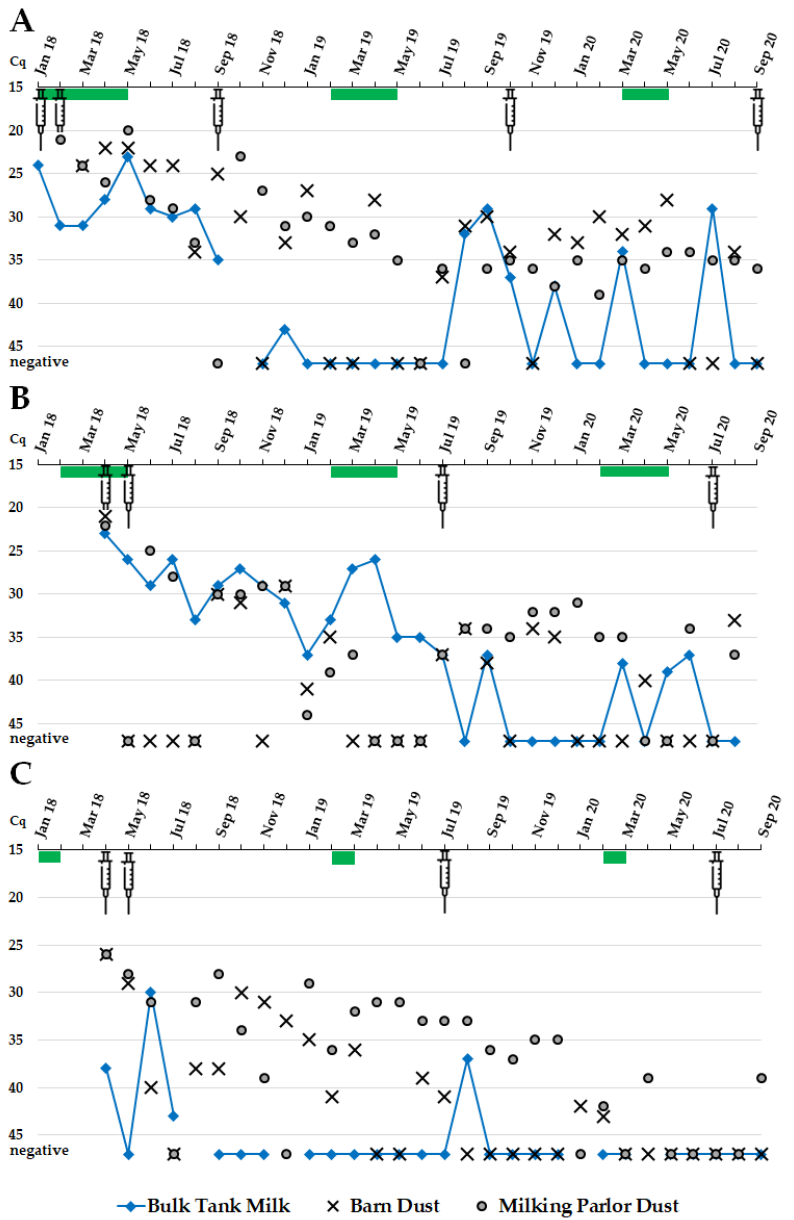
Figure 3. Coxiella burnetii detection by qPCR (Cq ≤ 45: positive result) in monthly collected bulk tank milk specimens ⬥ and dust samples from one windowsill of each barn ✖ and from each milking parlor ⚫ in three naturally C. burnetii infected and vaccinated dairy goat herds ( A – C ). BTM samples were not always available at every sampling date from farm A and C. Green bar: kidding period; syringe: vaccination; missing samples are not indicated.